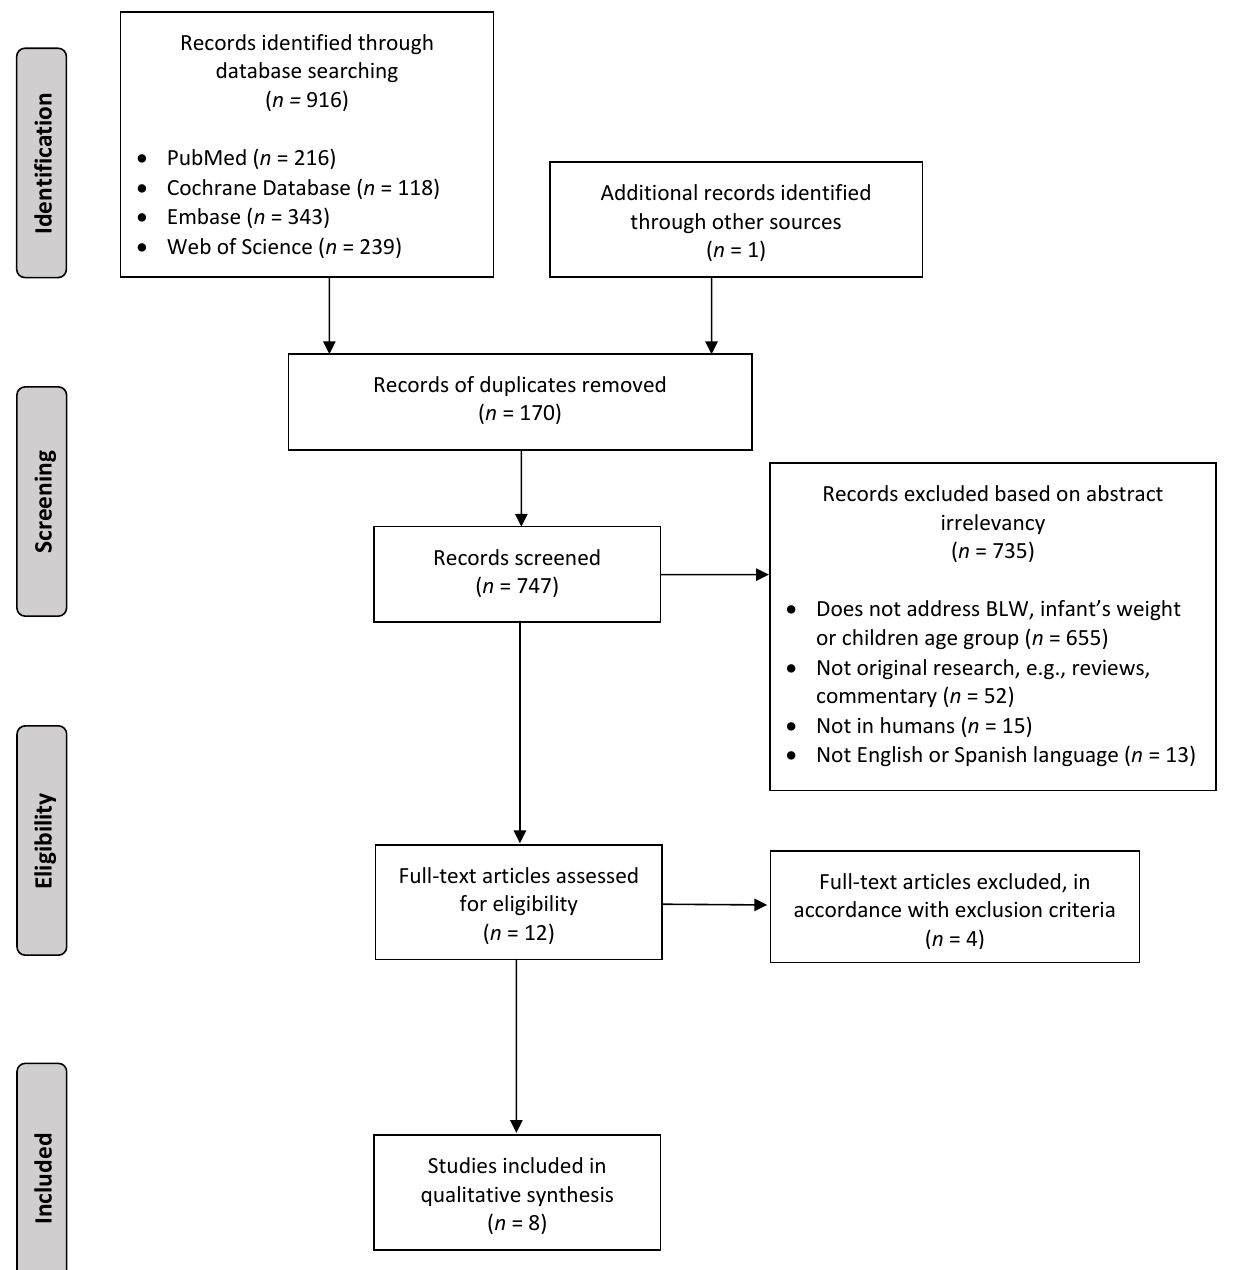
Figure 1. PRISMA Flow Diagram of the literature search and selection, according to the inclusion and exclusion